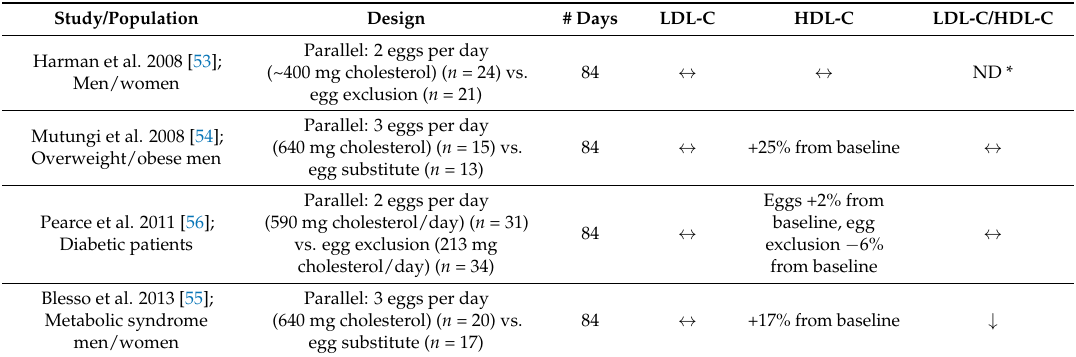
Table 3. Effects of additional dietary cholesterol from egg intake on serum lipids during weight loss.